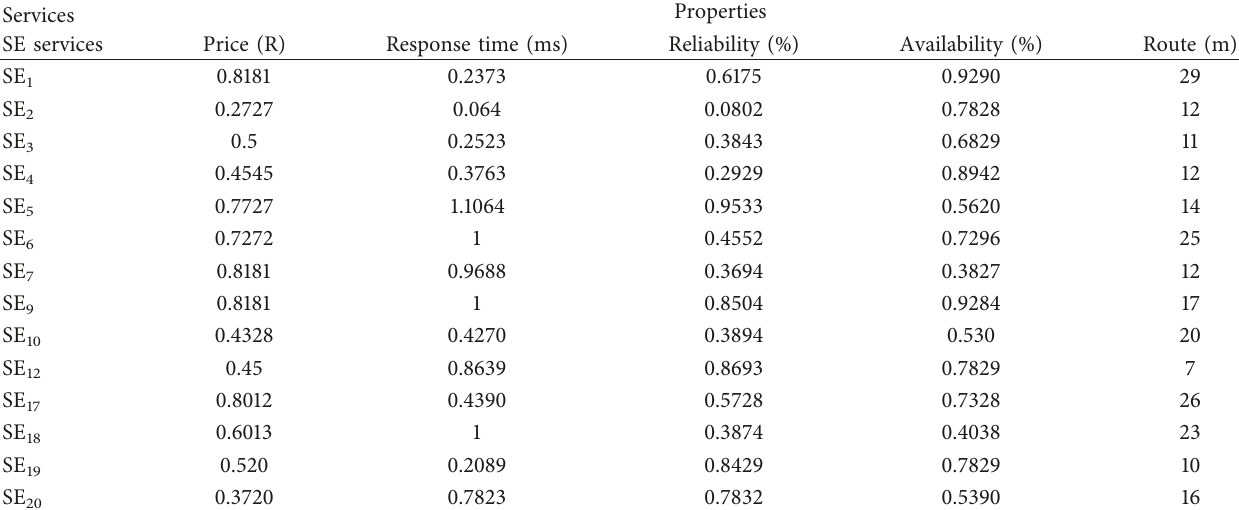
Table 2: Normalization of SE services.